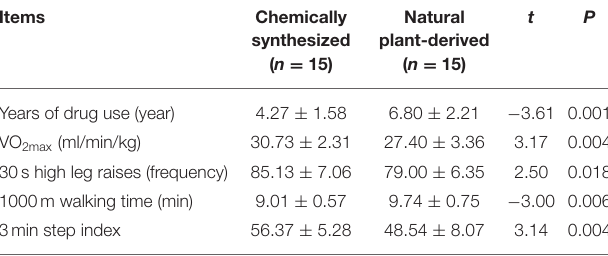
TABLE 2 | Statistics of test data of subjects ( n = 30, mean ±